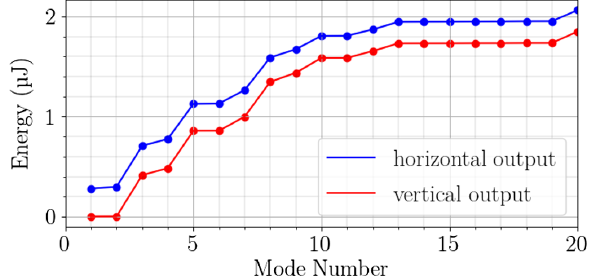
FIG. 20. Cumulative baseline IOM energies for a bunch with 100 μ m vertical offset.